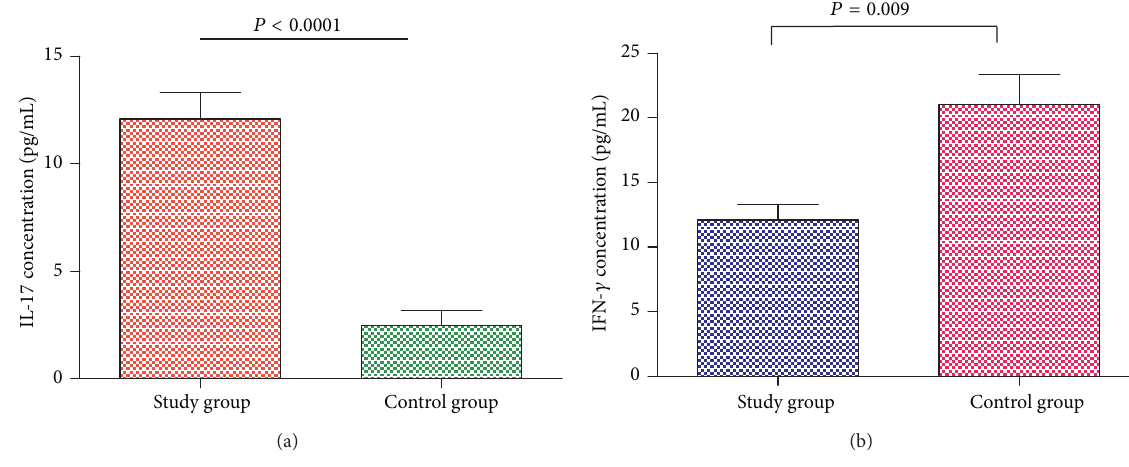
Figure 2: (a) IL-17 and (b) IFN- 𝛾 expression in study and control.